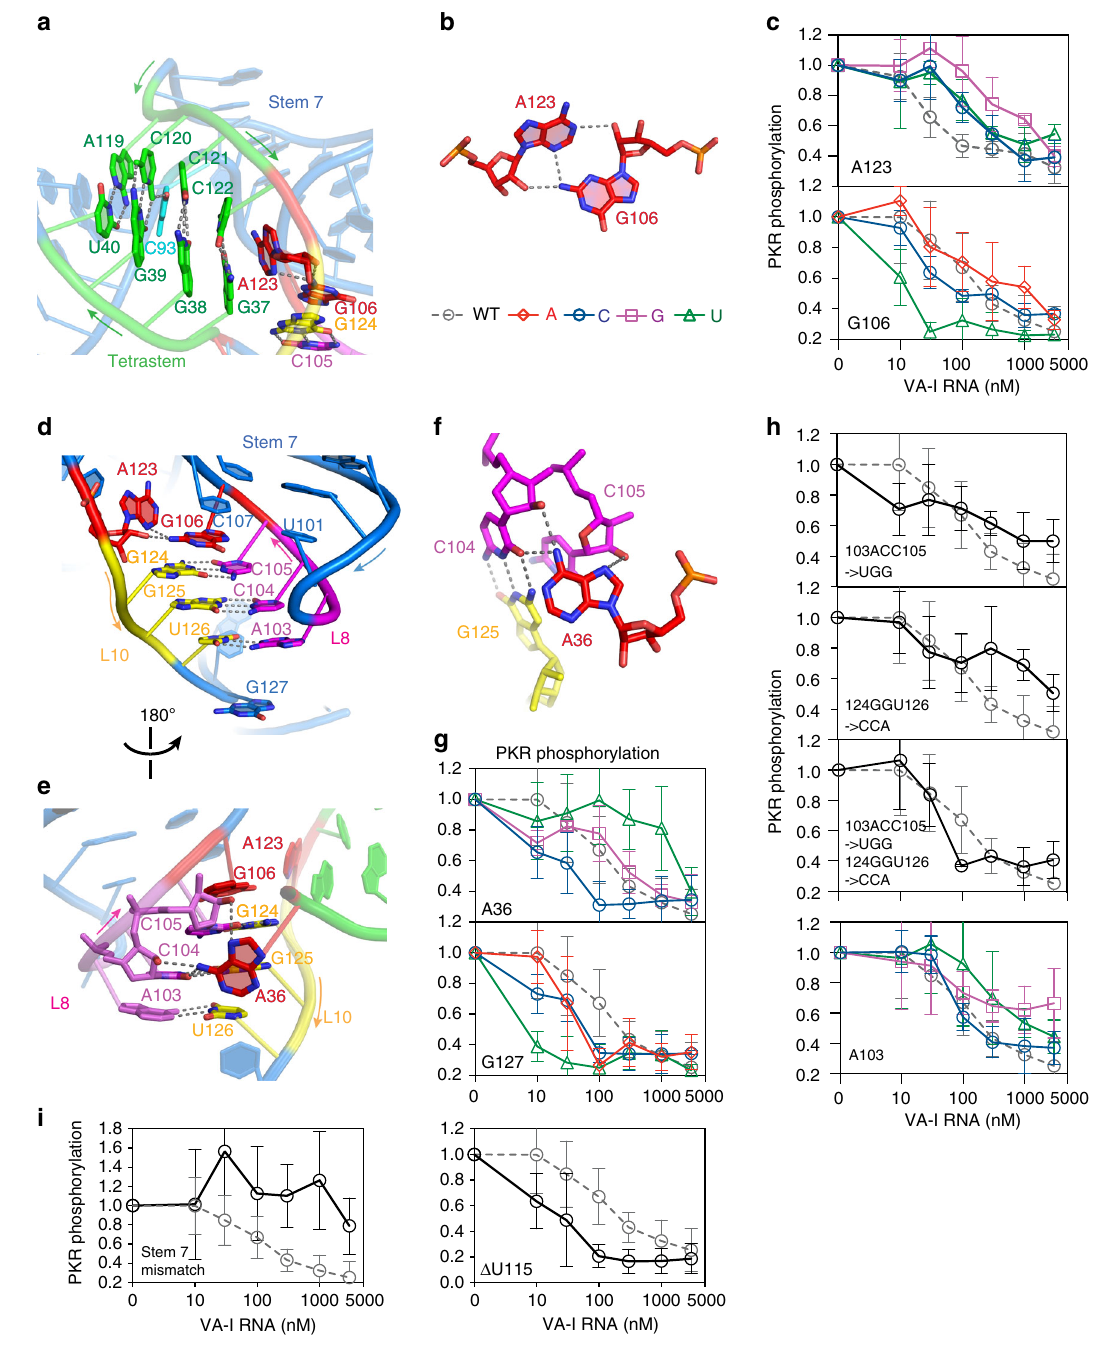
Fig. 4 Structure of the central domain. a A123 stacks with and caps the proximal end of the tetrastem. b Interactions between A123 and G106 connects the tetrastem to the central domain. c Effects of A123 and G106 substitutions on PKR inhibition. d – f Structure of the Loop 8 – Loop 10 pseudoknot and interactions with A36. g Effects of A36 and G127 substitutions on PKR inhibition. h Effects of pseudoknot disruptions on PKR inhibition. i Effects of Stem 7 alterations on PKR inhibition. Three mismatches in Stem 7 (G97U::G99U::G110U) abrogated PKR inhibition while Δ U115 enhanced VA-I potency. Error bars represent s.d. from three independent